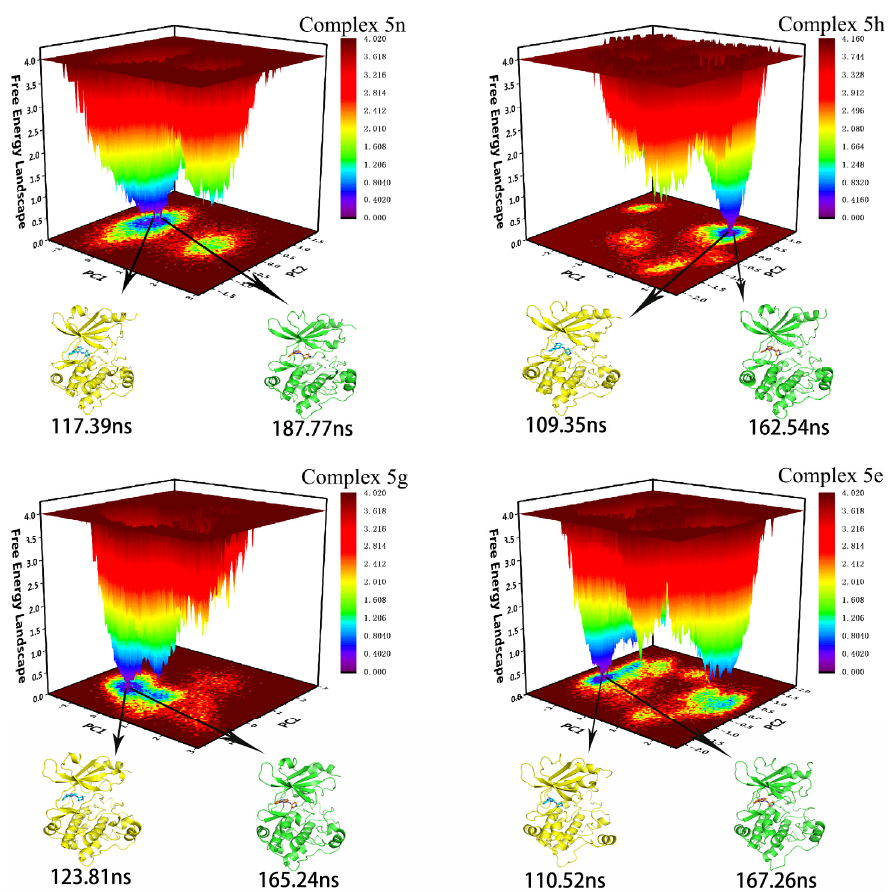
Figure 5. The free energy landscapes of four complex systems and the samples extracted from the MD simulation trajectories.